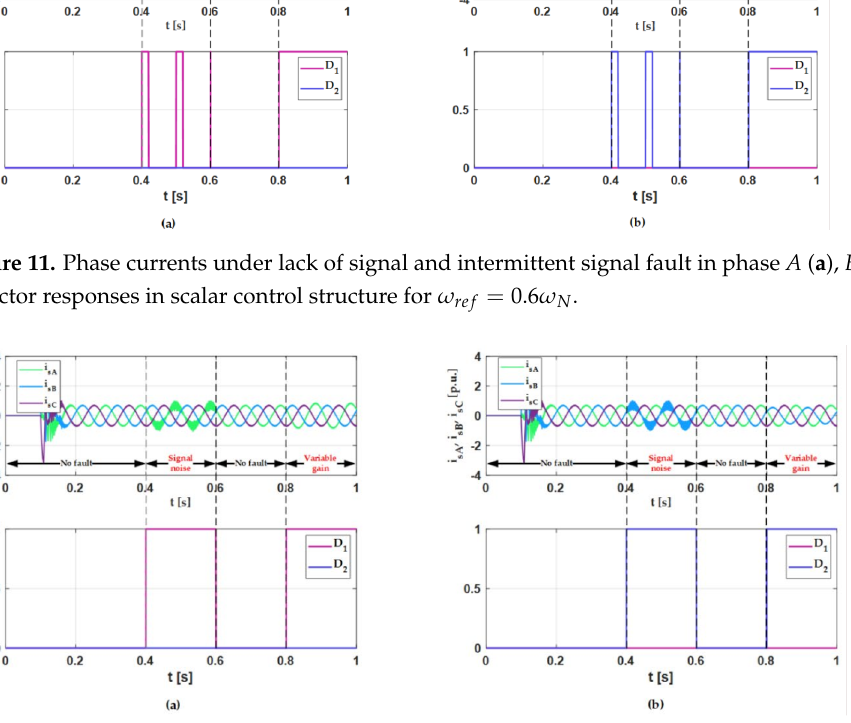
Figure 12. Phase currents under signal noise and variable gain (1.2 i m s ) fault in phase A ( a ), B ( b ) and detector responses in scalar control structure for ω ref = 0.6 ω N